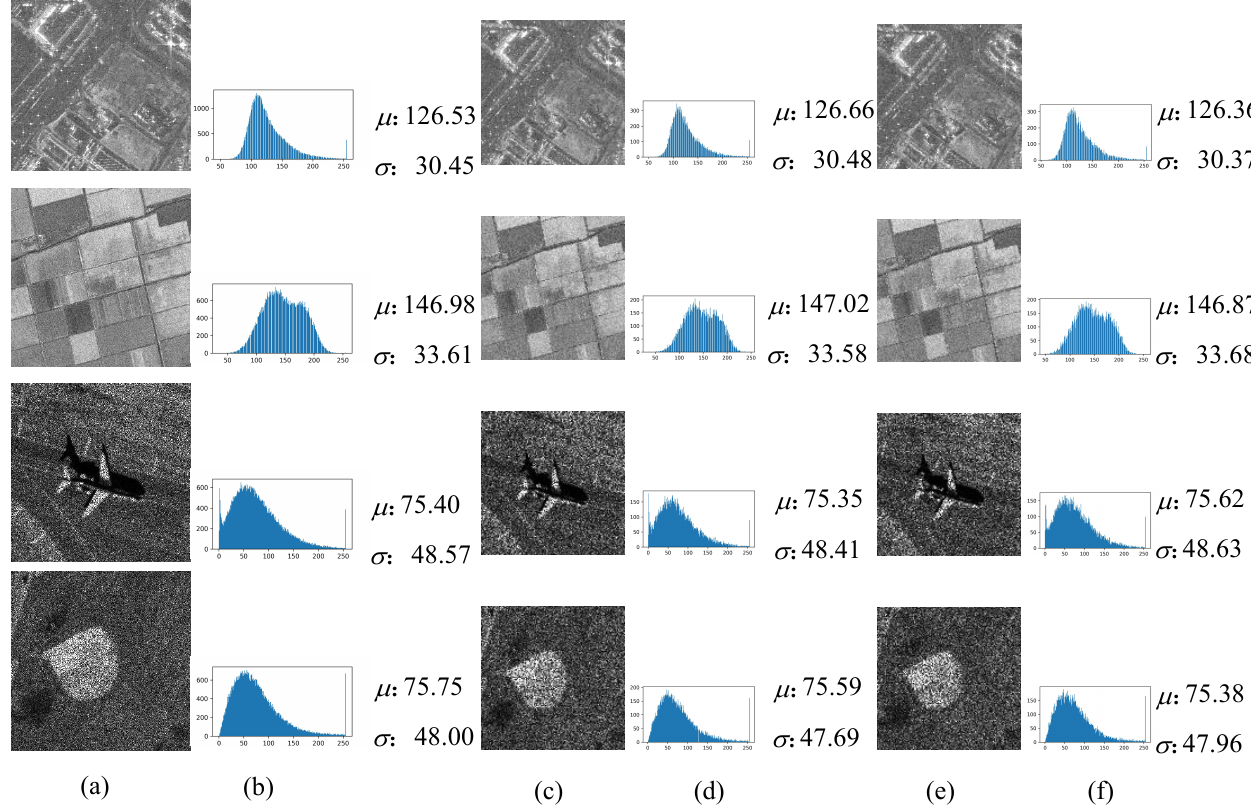
Figure 3. Examples of noisy-noisy image pairs using GTP module. ( a ) Original noisy images y . ( b ) Histograms of y . ( c ) Noisy images z 1 . ( d ) Histograms of z 1 . ( e ) Noisy images z 2 . ( f ) Histograms of z 2